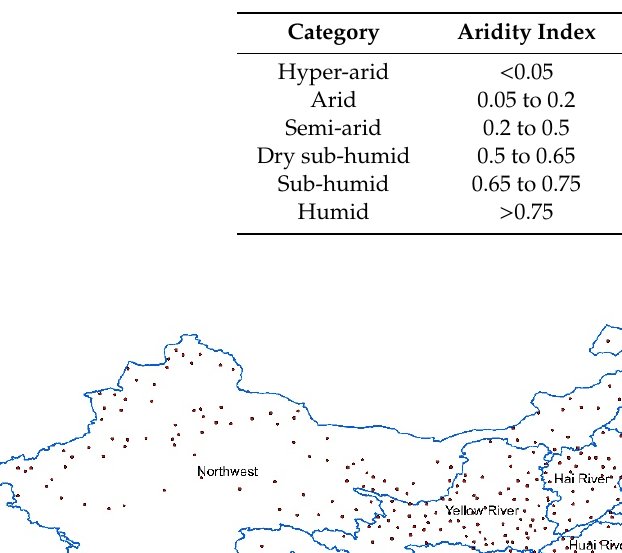
Table 1. Categories of aridity.